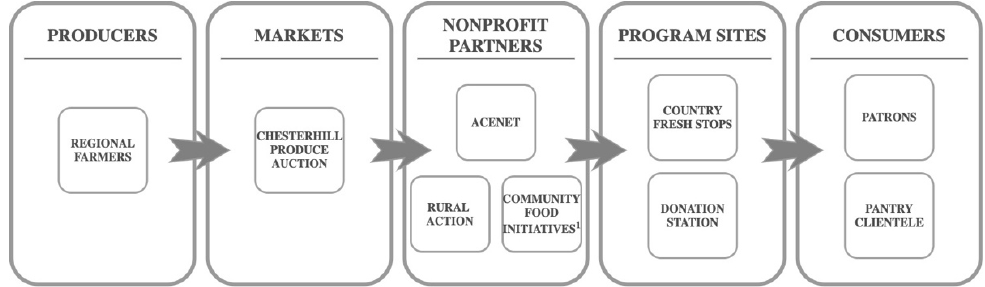
Figure 1. Country Fresh Stops and Donation Station: local value chain models for healthy food access. 1 CFI (Community Food Initiatives) supplements produce purchased from the Chesterhill Produce Auction with produce sold by regional farmers at the Athens Farmers Market. CFI also accepts donations of produce.